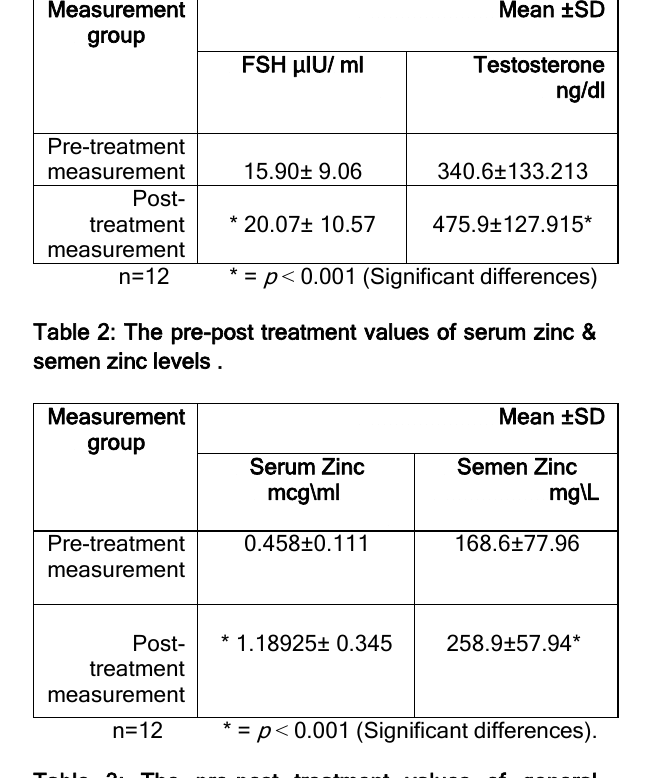
Table 3: The pre-post treatment values of